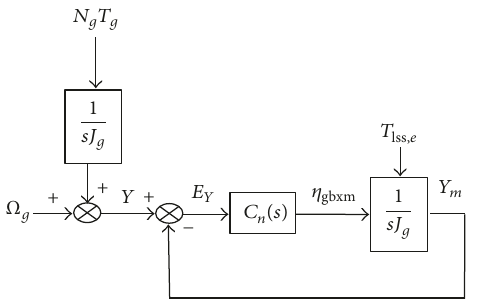
Figure 7: Gearbox efficiency detection scheme.